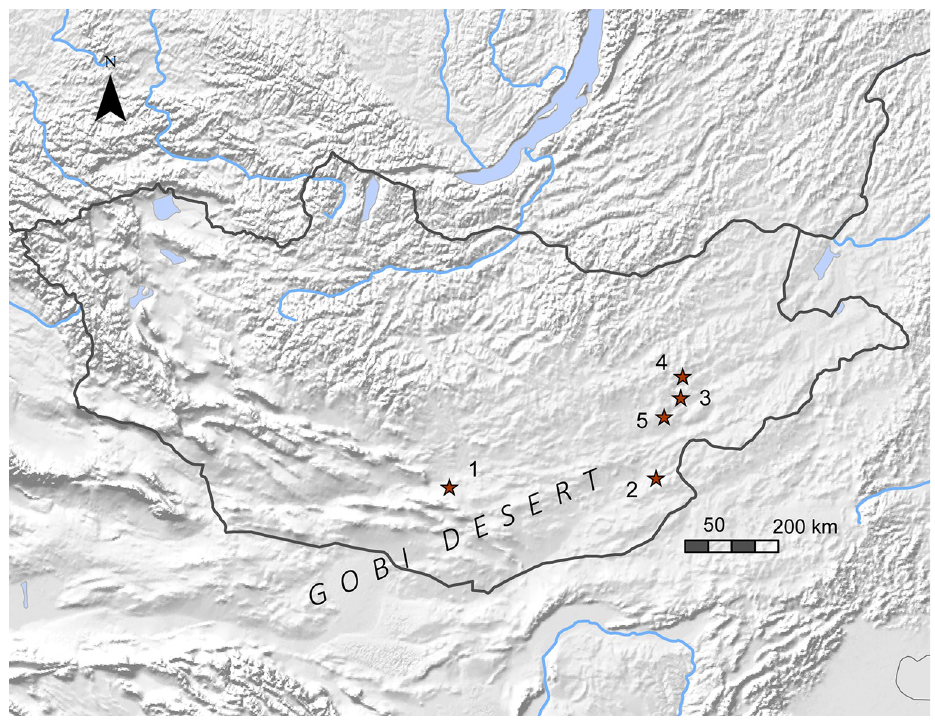
Fig 1. Map of Mongolia with sites mentioned in text: (1) Bayanzak/Shabarakh-usu, (2) Dulaani Gobi, (3) Zaraa Uul, (4) Delgerkhaan Uul, (5) Chandmani Khar Uul. Made with Natural Earth.